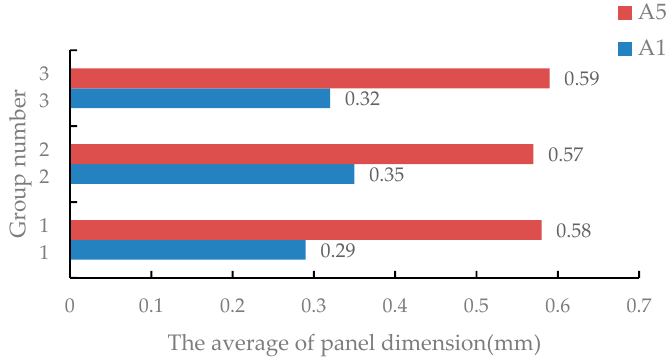
Figure 8 . Effect of the glue spread on panel dimension.